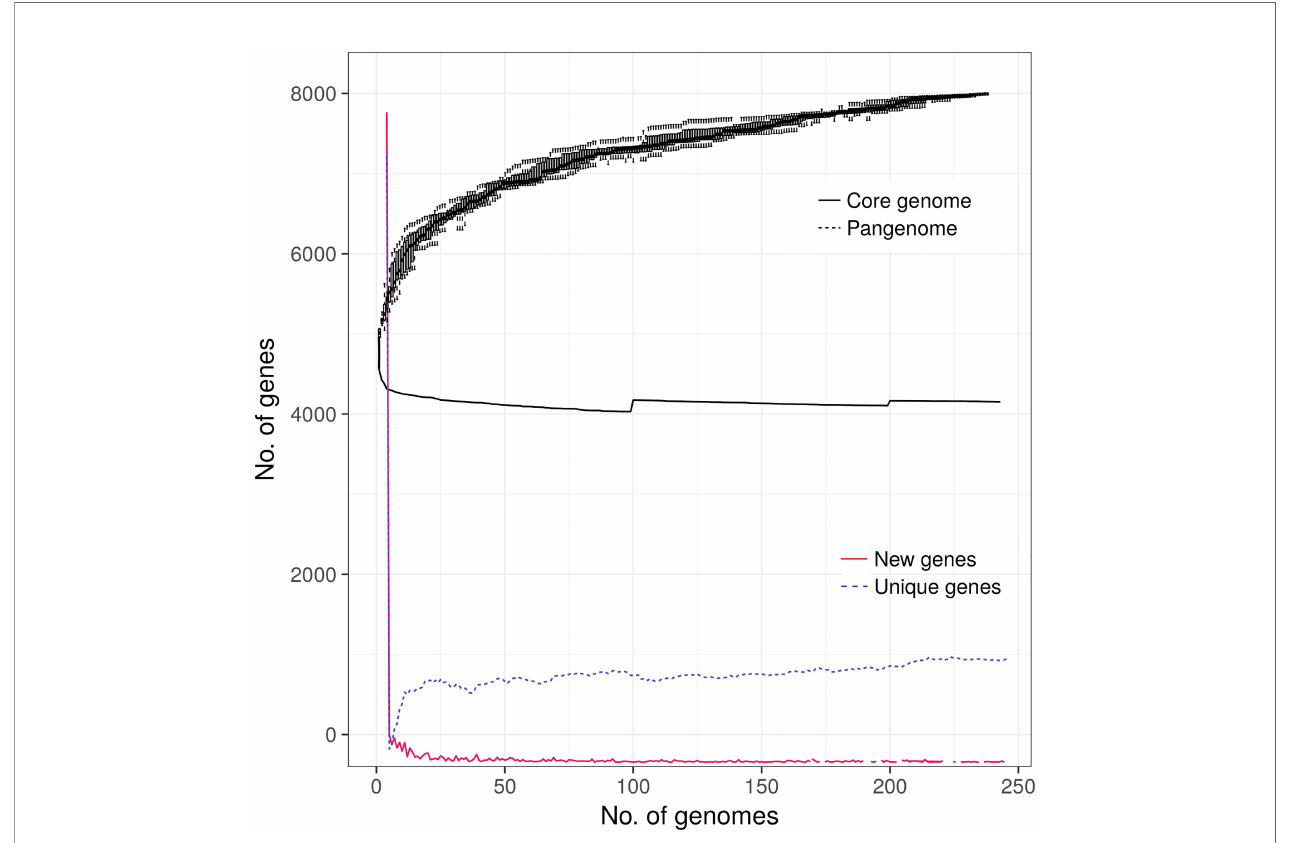
FIGURE 3 | Pangenome analysis of 248 Salmonella Kentucky ST198 originated from farm animals. Including the genomes of 19 isolates originated from animal sources in the African Horn region (this study) and 229 additional genomes publicly available in the